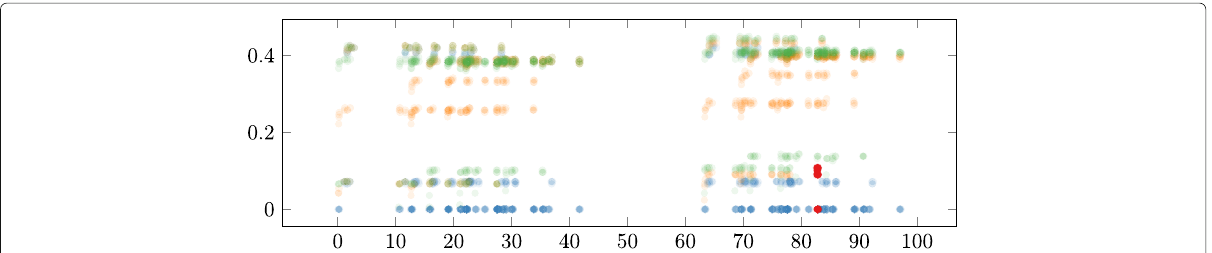
Fig. 5 Scatter plot of ROIA (ordinate, t 0 blue , t 1 orange , t 2 green ) and RFIA (abscissa) evaluations for all response plans. Note that both impact evaluations are almost uncorrelated, i.e., both actually evaluate an impact from perpendicular perspectives, and all dimensions must be considered equallyintheformofaPareto-efficientsettoobtainmeaningfulandvaluableresponses.ThetopfourPareto-efficientresponseplansaremarkedin